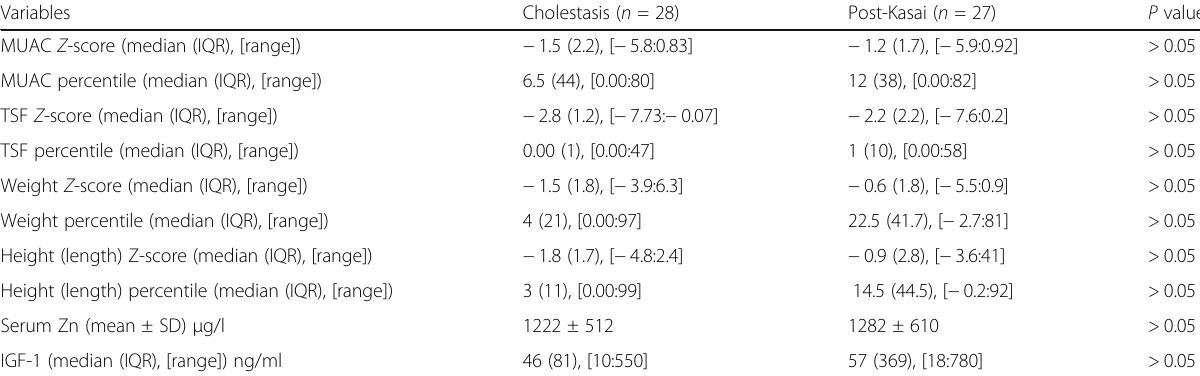
Table 3 Comparison between post-Kasai patients and other cholestatic patients before intervention Variables Cholestasis ( n = 28)